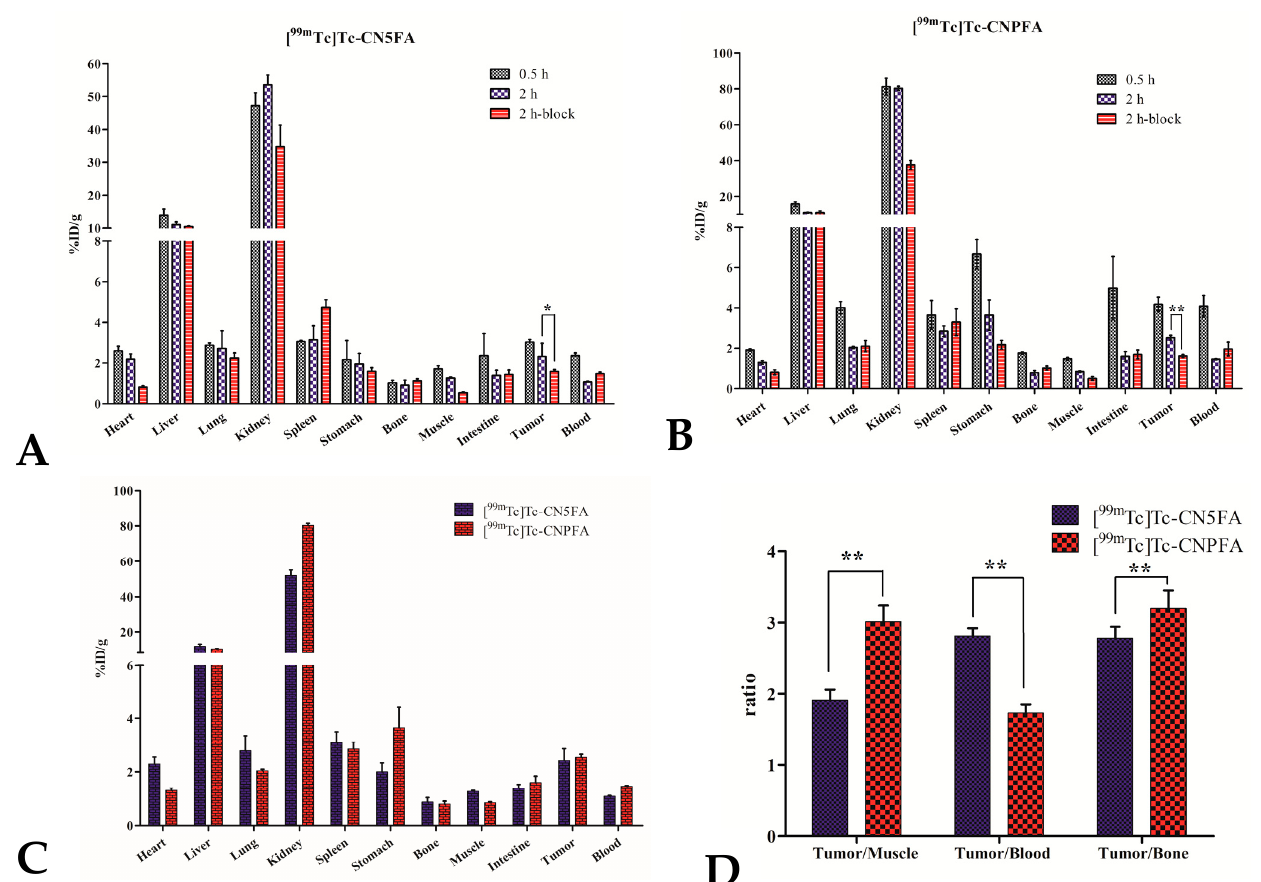
Figure 4. ( A ) Biodistribution of [ 99m Tc]Tc-CN5FA in KB tumor-bearing mice (* p < 0.05); ( B ) biodistribution of [ 99m Tc]Tc- CNPFA in KB tumor-bearing mice (** p < 0.01); ( C ) biodistribution of [ 99m Tc]Tc-CN5FA and [ 99m Tc]Tc-CNPFA in KB tumor-bearing mice at 2 h p.i.; ( D ) the ratios of tumor-to-nontargeted tissues of [ 99m Tc]Tc-CN5FA and [ 99m